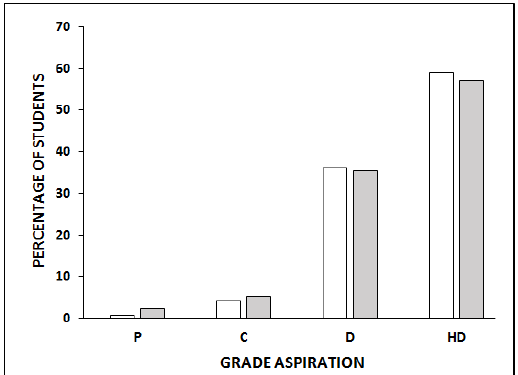
Figure 1: BIO1011 student grade aspirations, based on prior biology study (white columns, VCE Biology cohort) and no prior biology study (light grey columns, non-VCE Biology cohort) (n=550 and 251,